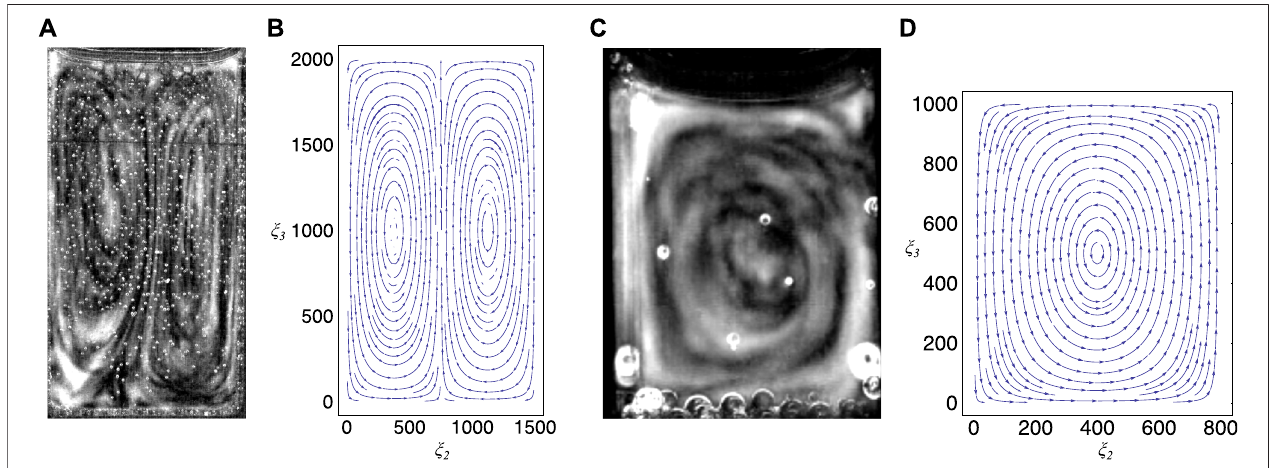
FIGURE8| Comparison between experiment and theory, (A) shows the convectioncells developed inaspecialcuvette inthechaoticphase (see also Figure 2A ), (B) showsastreamplotthatindicatesthe fi eldlinesofthevelocity fi eldgivenin formula(3) byusingthevaluesgiveninthetext, (C) showstheconvectioncellsdeveloped inapartly fi lledstandardcuvette(seealso Figure6D ), (D) showsastreamplotthatindicatesthe fi eldlinesofthevelocity fi eldgivenbythethree-dimensionalextensionof the model (for details, see